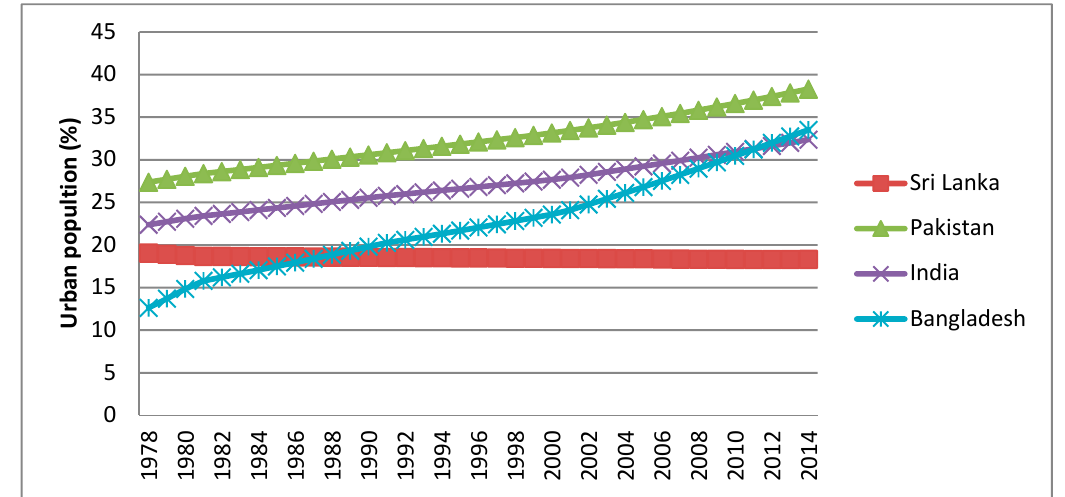
Figure 2. Urban population in selected South Asian countries.